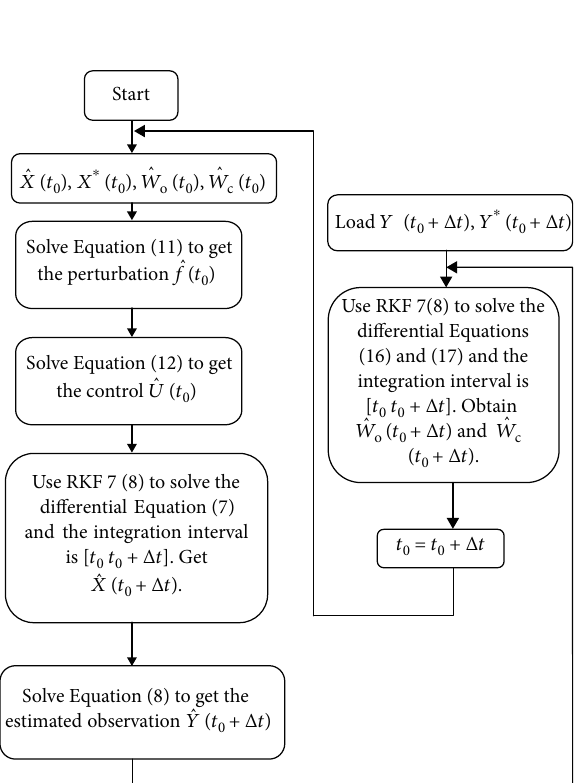
Figure 4: The structure of the system.